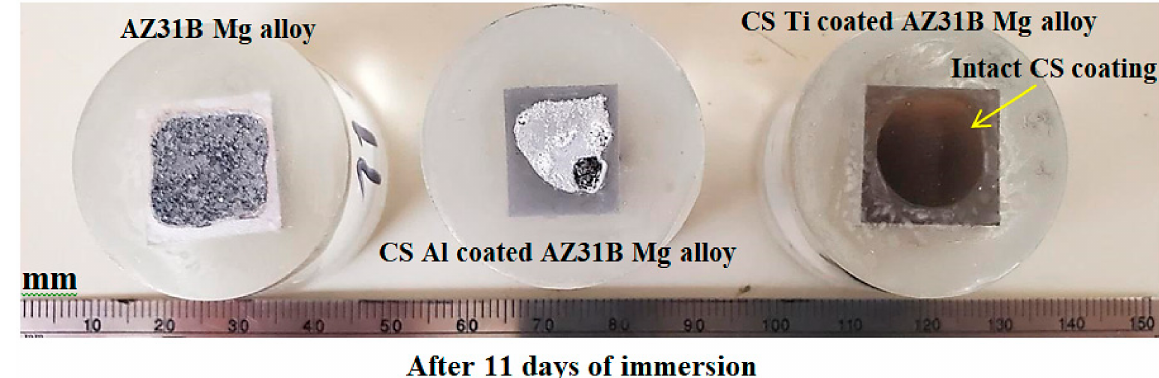
Figure 12. Photos of uncoated AZ31B Mg alloy, Al-coated AZ31B Mg alloy, and Ti-coated AZ31B Mg alloy (from left to right) after immersion test in 3.5 wt % NaCl solution for 11